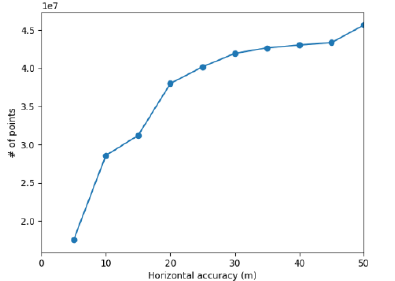
Figure 1. Threshold selection for the GPS horizontal accuracy Human movement pattern analysis will only use GPS data on weekdays since there are only two weekends in this dataset, which may not be sufficient to draw any solid